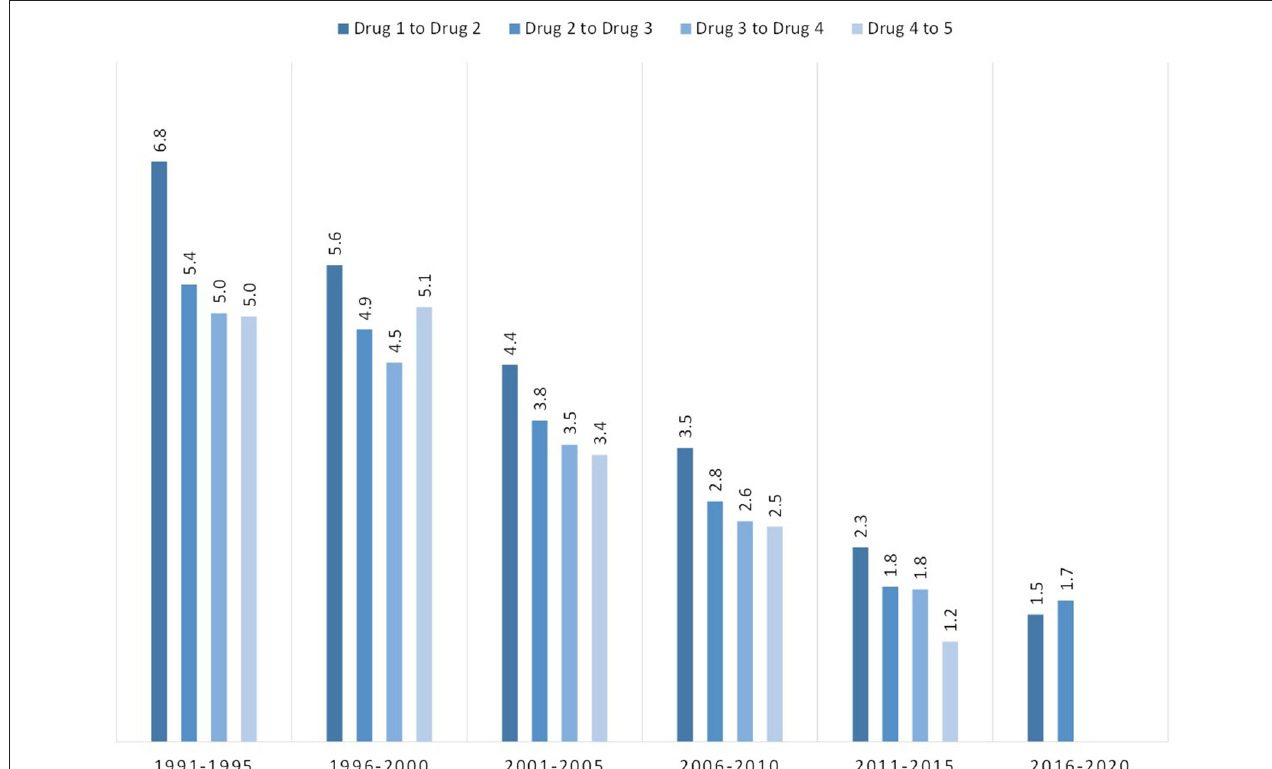
FIGURE 9 | Mean number of years between drug exposures, grouped by year of initial drug exposure.